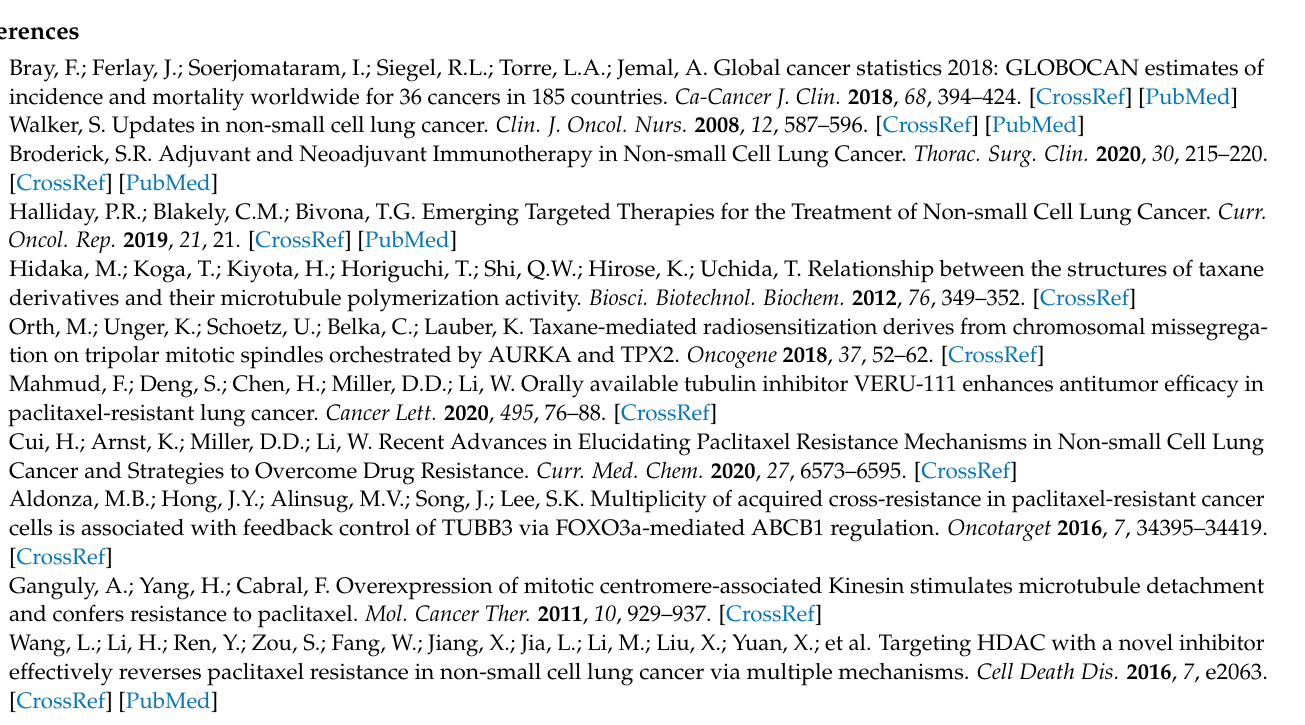
Figure S3: Flow cytometry (FACS) analysis using PI staining showed combination treatment induced Figure S4: SPA70 and combination regimen induced necroptosis and exacerbated cell